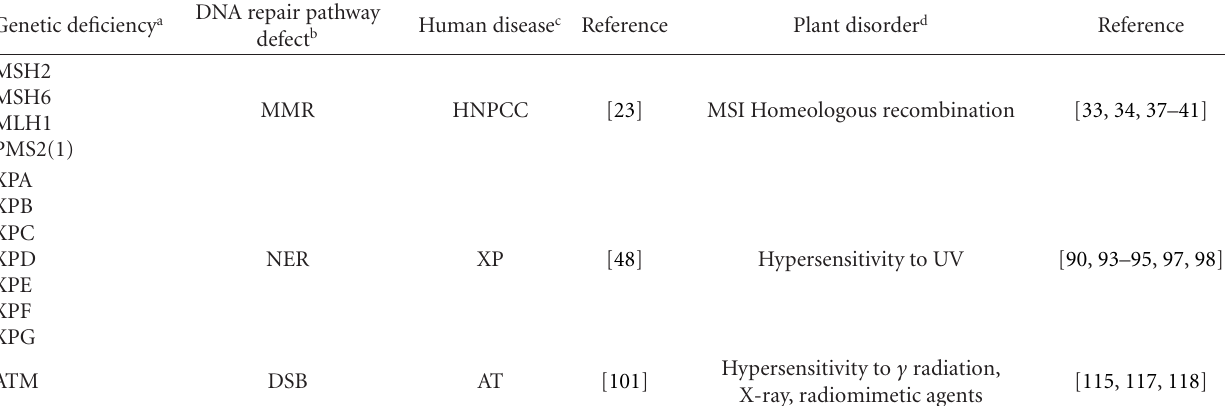
Table 1: Overview of studies linking DNA repair pathways and disorders in humans and